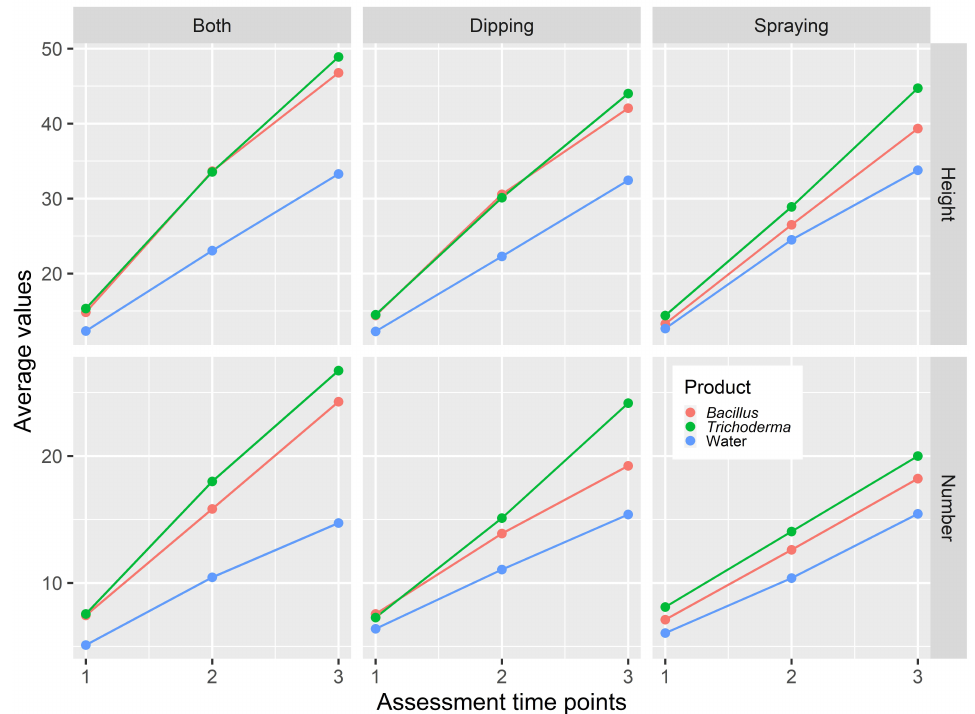
Figure 6. Average tiller number and height (cm) of rice plants that received one of the three products was applied at different times (dipping at transplanting, foliar spraying post-transplanting, or at both times) at three sites in 2020 and 2021 in